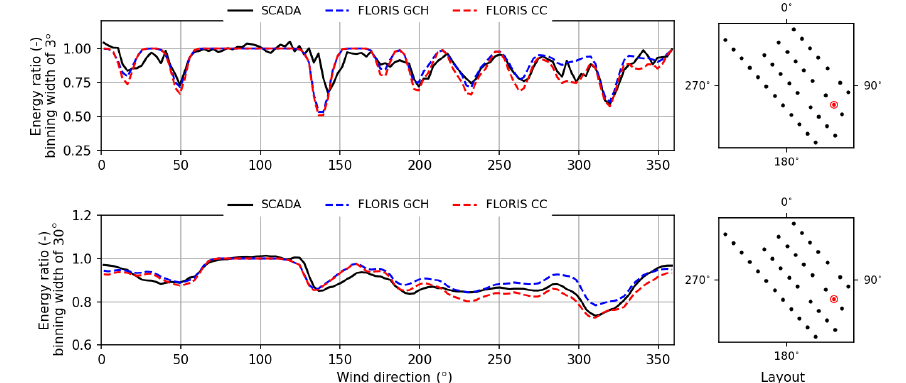
Figure 15. Energy ratio versus wind direction for a turbine located in the southeast region of the OWEZ wind farm. Note there is a lack of data for wind directions less than 150 ◦ , potentially explaining the larger mismatch for the wake centered at 140 ◦ . The reference turbines to which the energy ratio is normalized are the turbines that are both operating in freestream flow and within a 5km radius of Turbine 22. The reference wind direction is determined by the nacelle headings from turbines directly neighboring Turbine